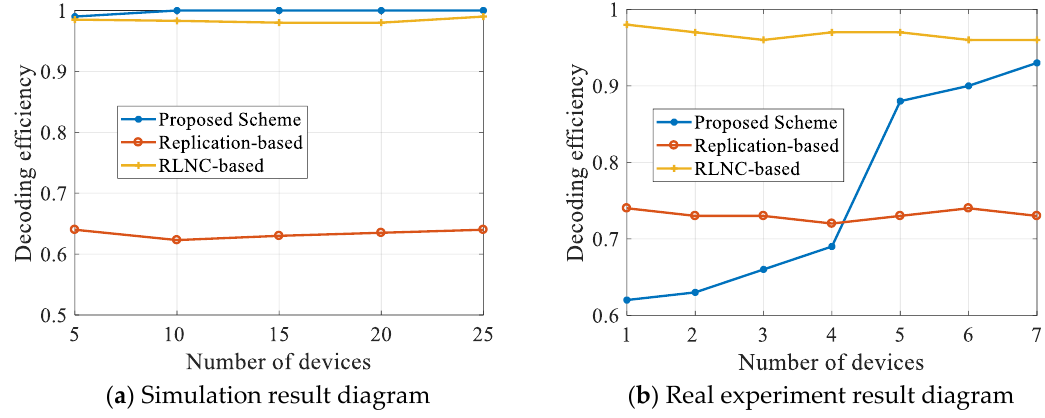
Figure 5. Influence of equipment quantity on SDR.